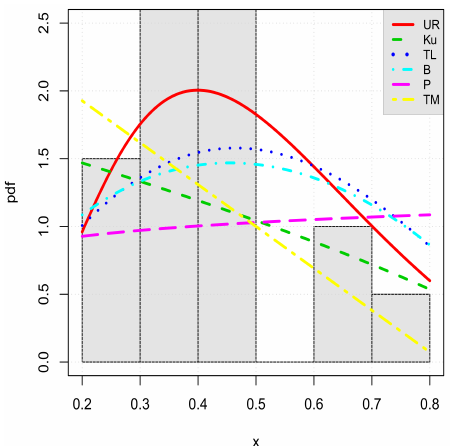
Figure 10. Plots of the estimated pdfs of the considered models for the flood level data set.